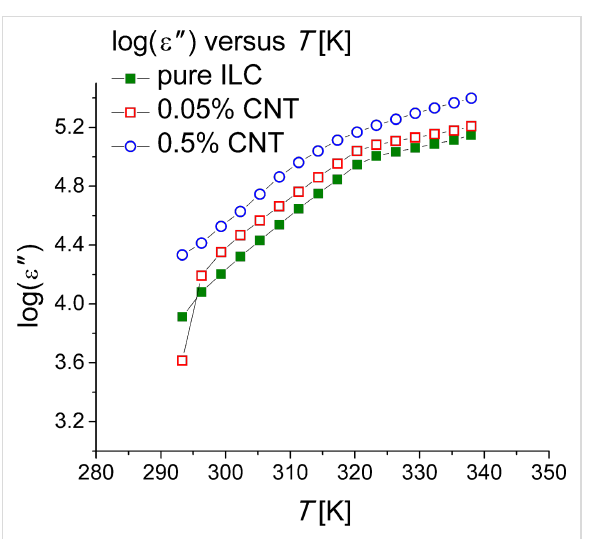
Figure 6: Dielectric loss as a function of the temperature (logarithmic scale) for pure ILC (green solid squares), ILC doped with 0.05% CNTs (red open squares) and ILC doped with 0.5% CNTs (blue open circles).